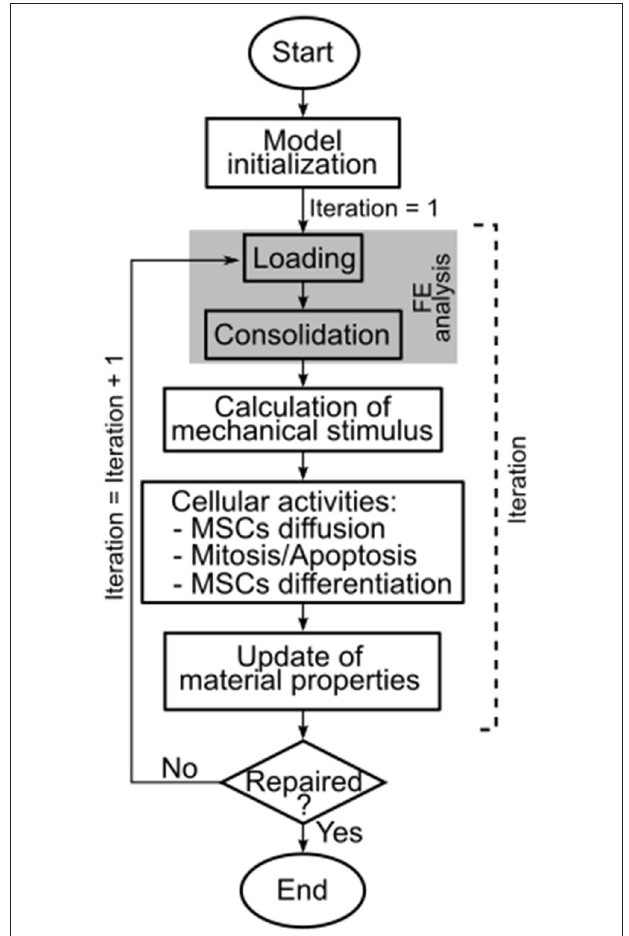
FIGURE 3 | Workflow of the here presented model. The model ran until completion of the repair process, which was reached at iteration 50. FE = finite element.